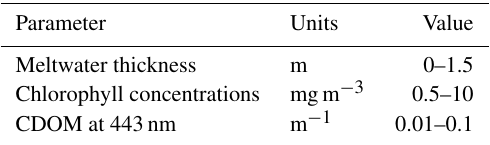
Table A2. Physical parameters of meltwater on ice and ocean water. Meltwater thickness and CDOM values follow randomly distributed uniform distributions in the specified ranges. For the chl a concen- tration, a reciprocal continuous distribution (long tail extending to high values) was used.